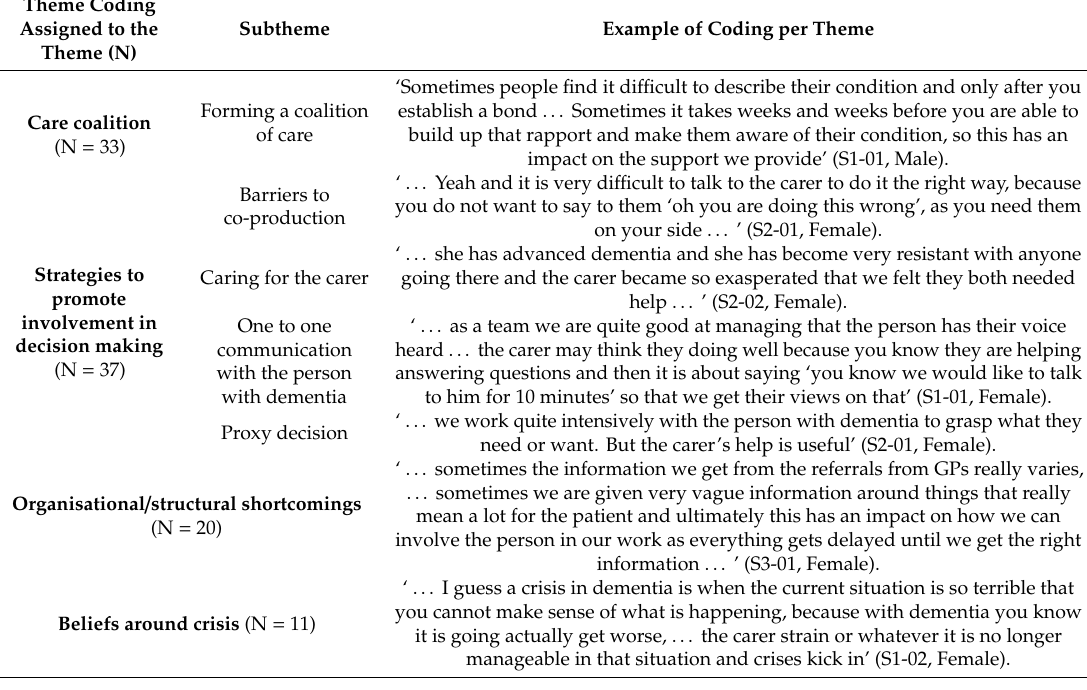
Table 1. Analytic description of